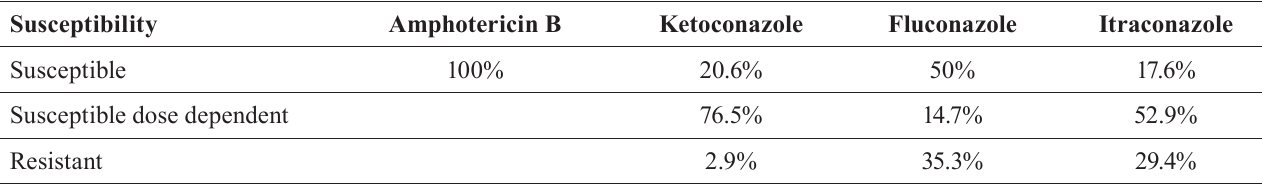
Table III – Susceptibility profile of isolates of Candida albicans collected from vaginal content to